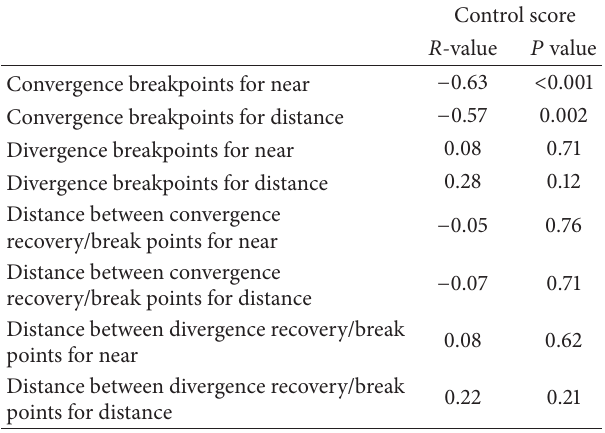
Figure 1: Comparison of the fusional vergence detected using a prism bar in patients with IXT and normal subjects. The mean convergence amplitude was significantly lower for children with IXT compared with normal children at both distance and near (distance: 18.65 ± 1.50 versus 26.46 ± 1.53 pd, 𝑃 < 0.001 ; near: 18.20 ± 1.59 versus 31.08 ± 1.40 pd, 𝑃 < 0.001 ). The mean divergence amplitudes were significantly greater for children with IXT than for normal children (distance: 18.75 ± 0.99 versus 8.81 ± 0.32 pd, 𝑃 < 0.001 ; near: 24.69 ± 1.33 versus 15.91 ± 0.46 pd, 𝑃 < 0.001 ). The mean distance between the recovery and break points for both convergence and divergence was significantly larger at both distance and near for IXT children compared with normal subjects (for convergence, distance: 7.67 ± 1.06 versus 5.21 ± 0.51 pd, 𝑃 = 0.02 ; near: 8.13 ± 1.19 versus 5.30 ± 0.44 pd, 𝑃 = 0.02 ; for divergence, distance: 4.76 ± 0.72 versus 2.18 ± 0.08 pd, 𝑃 < 0.001 ; near: 6.33 ± 0.79 versus 2.26 ± 0.10pd, 𝑃 < 0.001 ). Table 3: Correlation between control of deviation and fusional vergence detected using a prism bar.